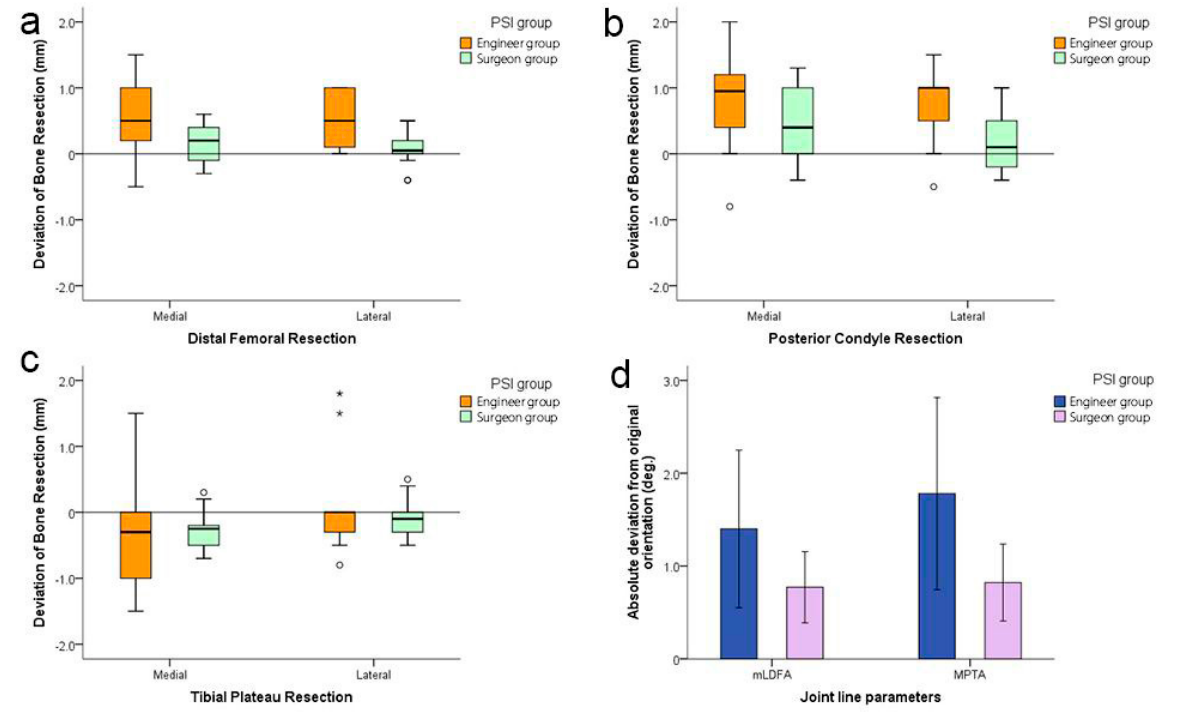
Figure 8. The effects of doctor-designed PSI on bone resection accuracy ( a – c ) and joint line restoration ( d ). Note: Asterisks and circles in plots represent outliers.